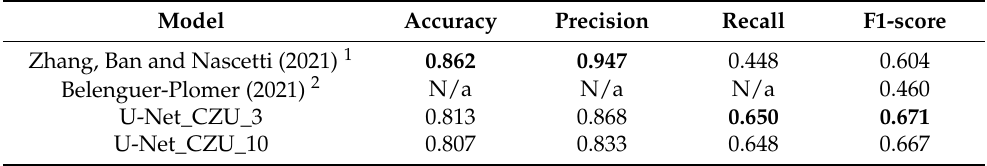
Table 5. CZU Lightning Complex U-Net Segmentation Results.: 1 Based on the U-Net with Learning without forgetting with SAR based reference mask for the Sydney Fire (2019-2020); 2 Based on North American study area S-1 satellites only. Model Accuracy Precision Recall F1-score Zhang, Ban and Nascetti (2021)